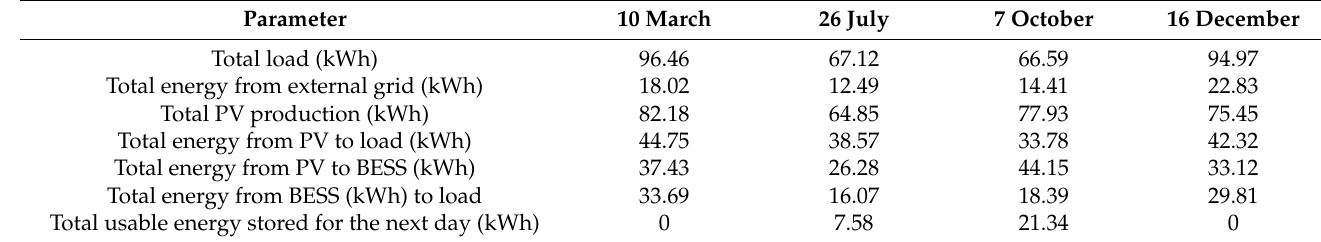
Table 4. Energy mix total